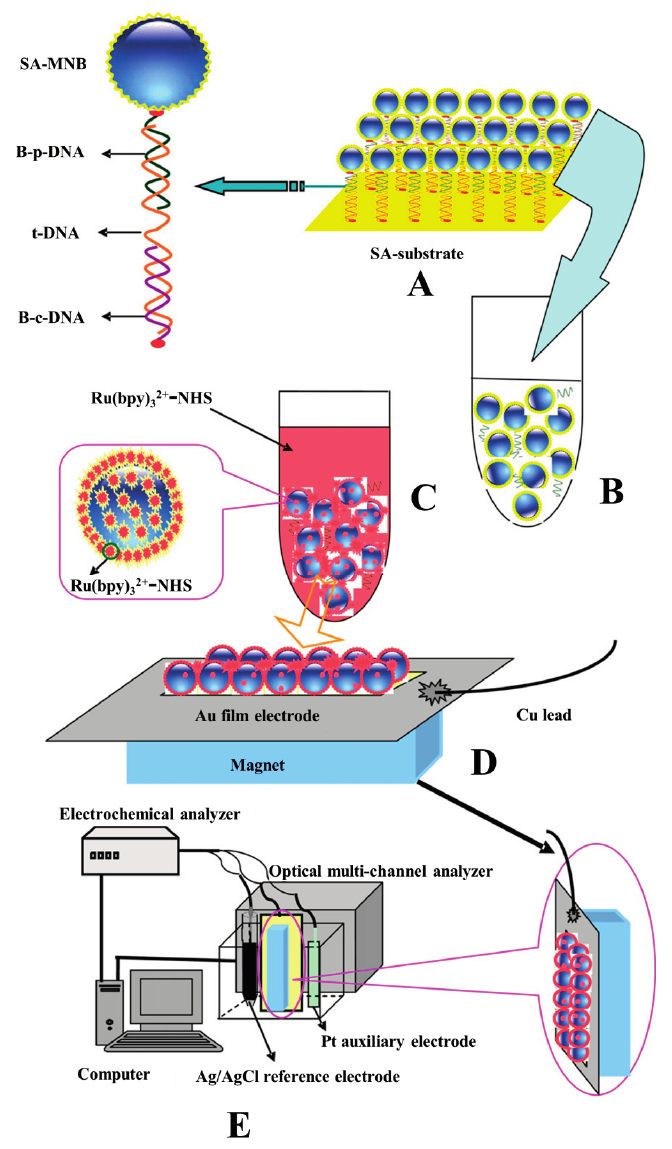
Figure 11. Schematic representation of the process of ECL spectrometry for determination of DNA by a combination of magnetic nanobeads attached with Ru(bpy) 32+ -NHS as labels and overview of the ECL spectrometry detection system. SA-MNB, streptavidin coated magnetic nanobead; B-p-DNA, biotinylated probe DNA; t-DNA, target DNA; B-c-DNA, biotinylated capture DNA; NHS, N-hydroxysuccinimide ester. Reprinted with permission from ref. [180], copyright (2012)